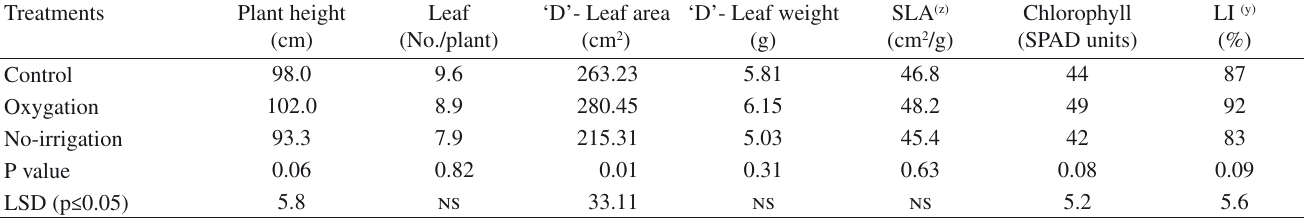
exchange rate, stomatal conductance, transpiration rate, and leaf temperature for different treatments 2